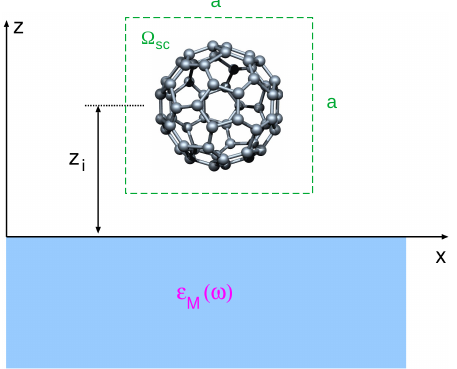
Figure 3. The fullerene molecule C 60 centered at z = z i is physisorbed at the supporting crystal occupying the half-space z < 0, with the dielectric properties approximated by the macroscopic dielectric function (cid:101) M ( ω )